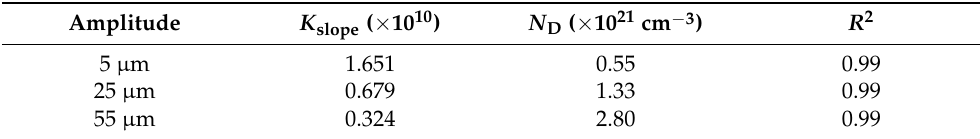
Table 3. Fitting parameter of Mott–Schottky plots and calculated values of samples with different amplitudes.